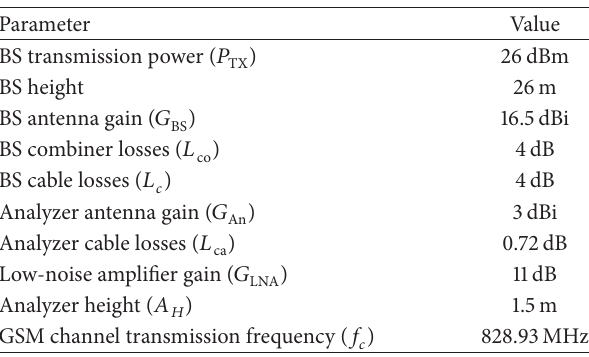
Table 1: BS parameters and spectrum analyzer.